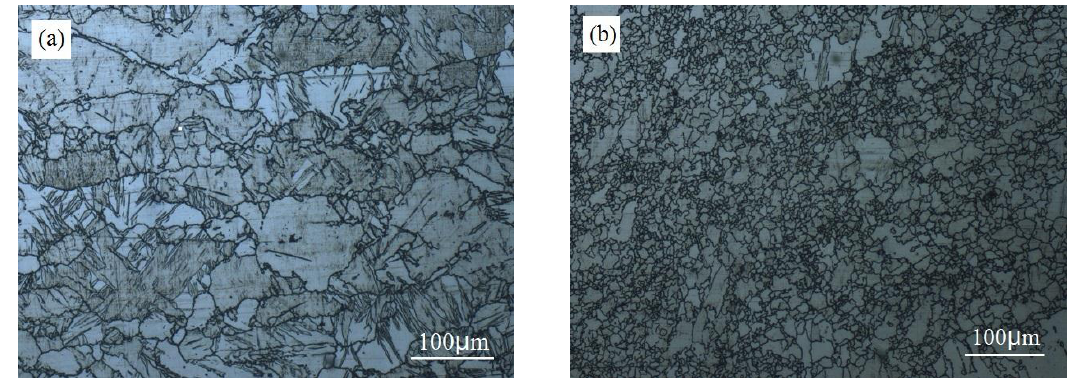
Figure 6. Microstructure evolution of different locations ahead the tool keyhole: ( a ) the region next to the base material; ( b ) the region next to the stirring pin.